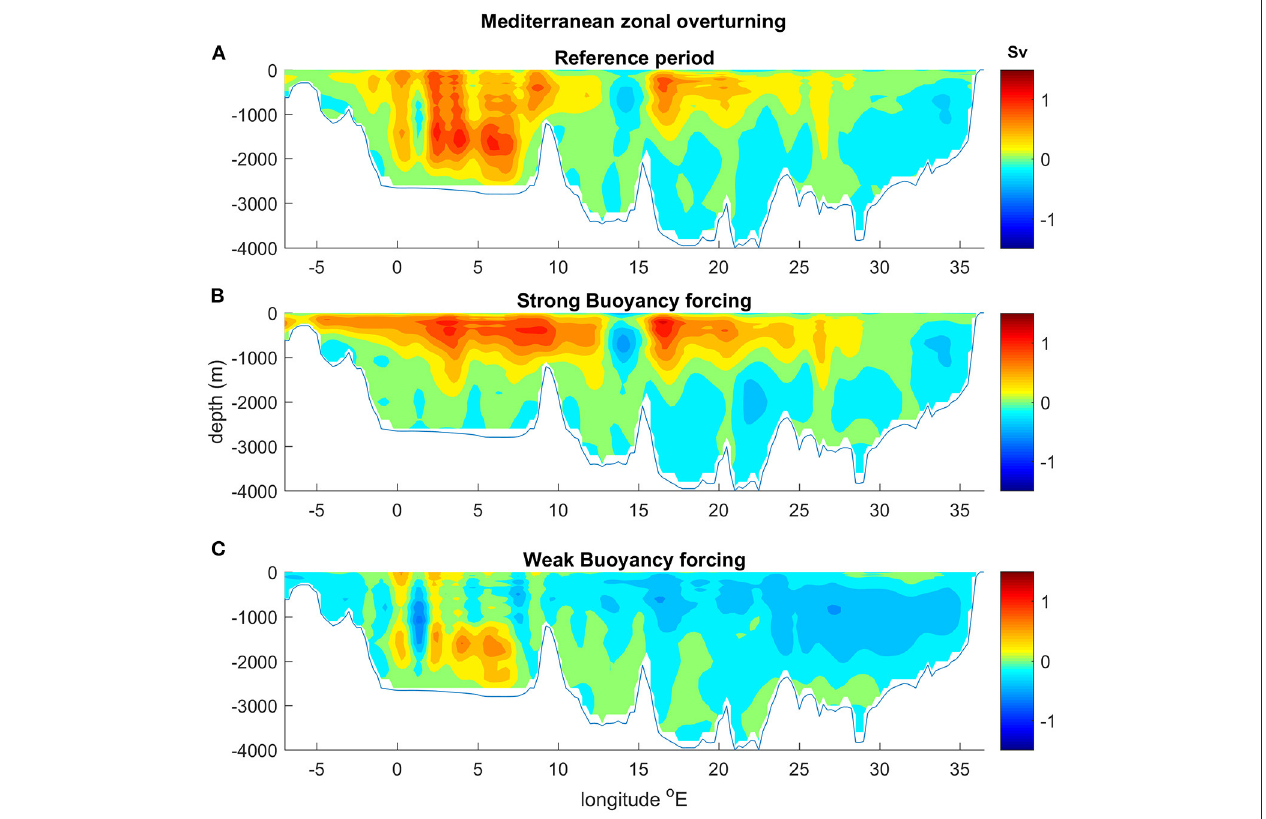
FIGURE 4 | The Mediterranean zonal overturning transport (estimated via streamfunction computation) for (A) the reference period, (B) the SBF, and (C) the WBF, as produced by the model experiments under the diagnosed fluxes. The transport is given in Sverdrups.